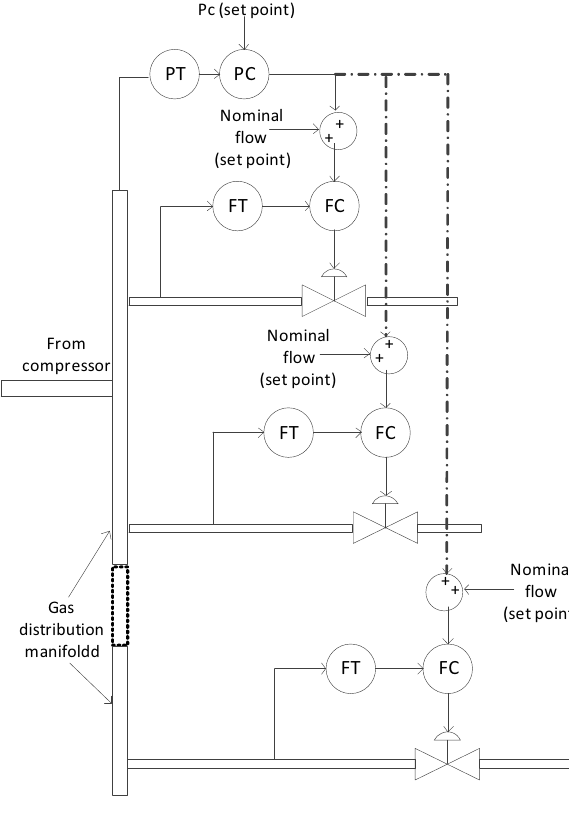
Figure 4: Schematic for cascade control